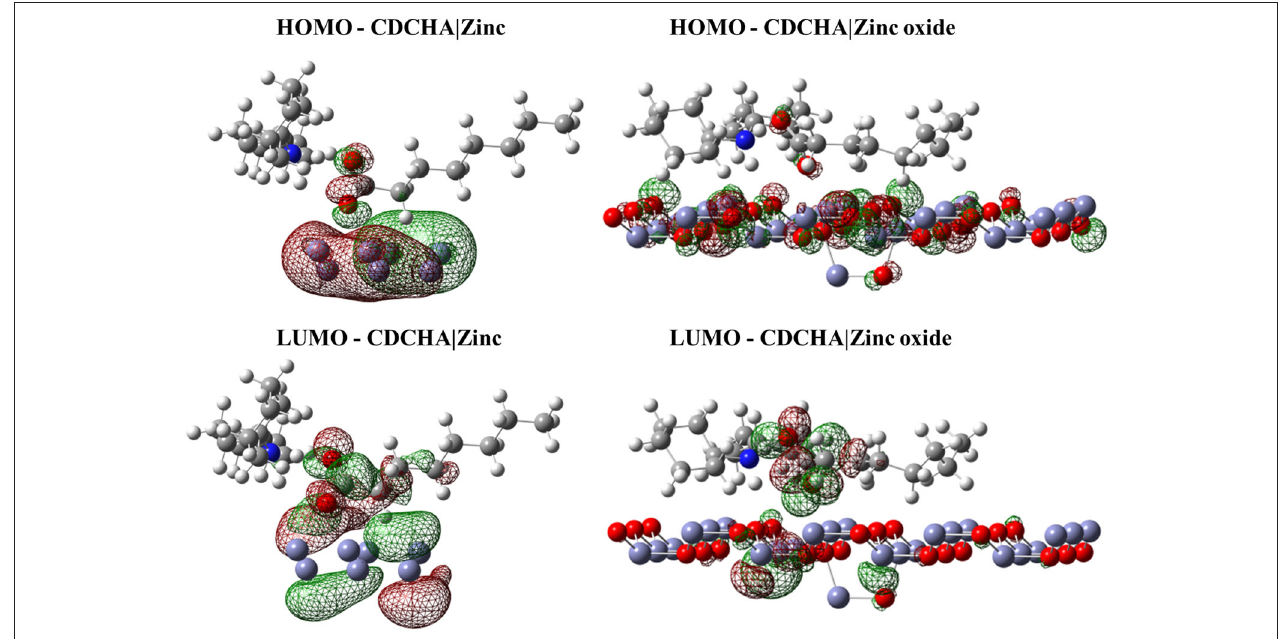
FIGURE 3 | Isodensity surfaces (density value = 0.0001 A − 3 ) of HOMO and LUMO orbitals of CDCHA molecule with the zinc and zinc oxide surfaces. The red color represents the negative part of the wave function and the green color corresponds to the positive